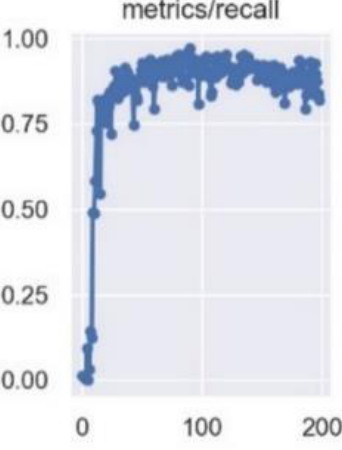
Figure A15. The change of mean average precision (mAP) of YOLOV5x: ( a ) mAP_0.5; ( b ) mAP_0.5:0.95.